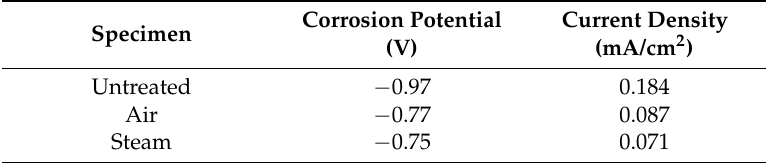
Table 4. Corrosion potential and corrosion current density for each specimen.